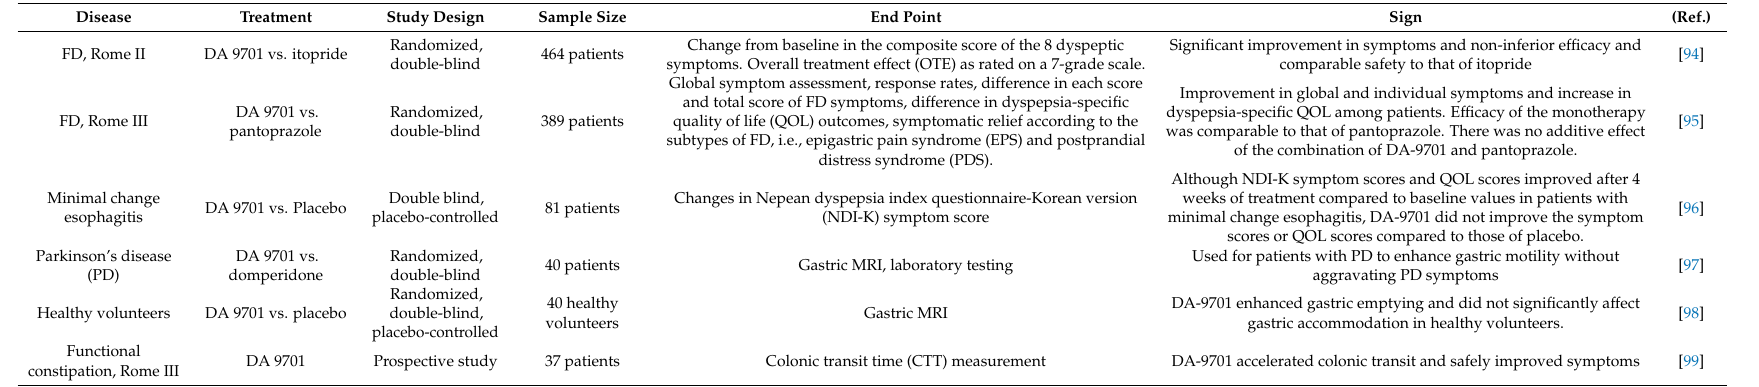
Table 2. Clinical trials using